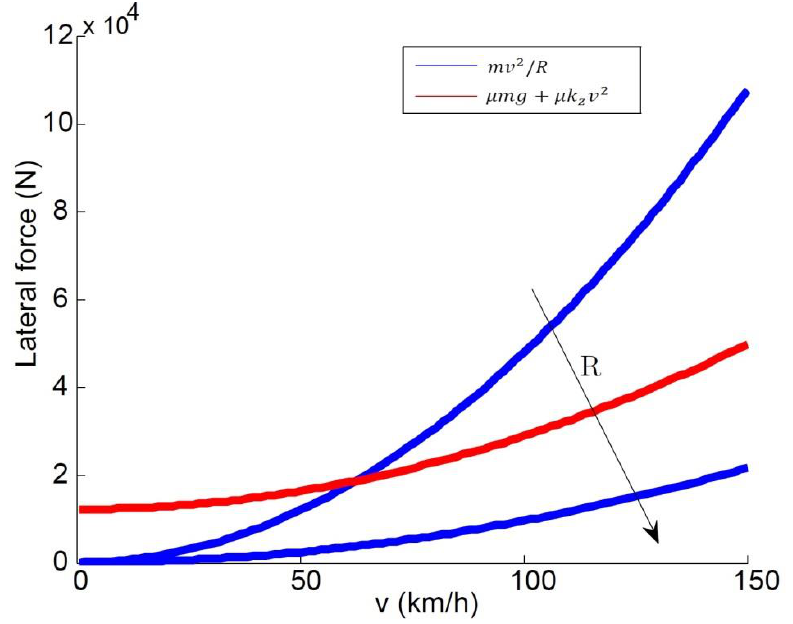
Figure 4. Maximum achievable speed as a result of the grip and critical radius of the curvature.